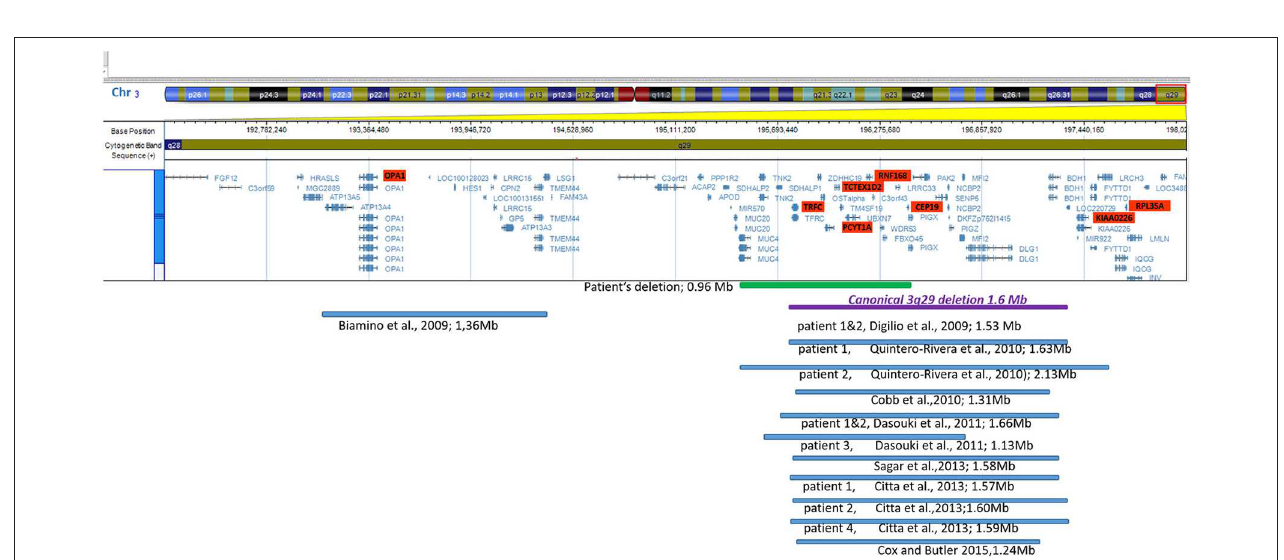
FIGURE 3 | Ideogram of chromosome 3 with zoomed-in details of the 3q29 band shown with a schematic view of the genes involved in the deletion. Horizontal lines in blue show proportional representation of deletion size in our patient and previously reported deletions in other patients (in order of publication year). Deletion limits were converted to GRCh37/hg19 reference (also shown in Table 2 ). The ideogram included the deletions reported in the literature which were detected by array. Cases reported using the FISH method were not